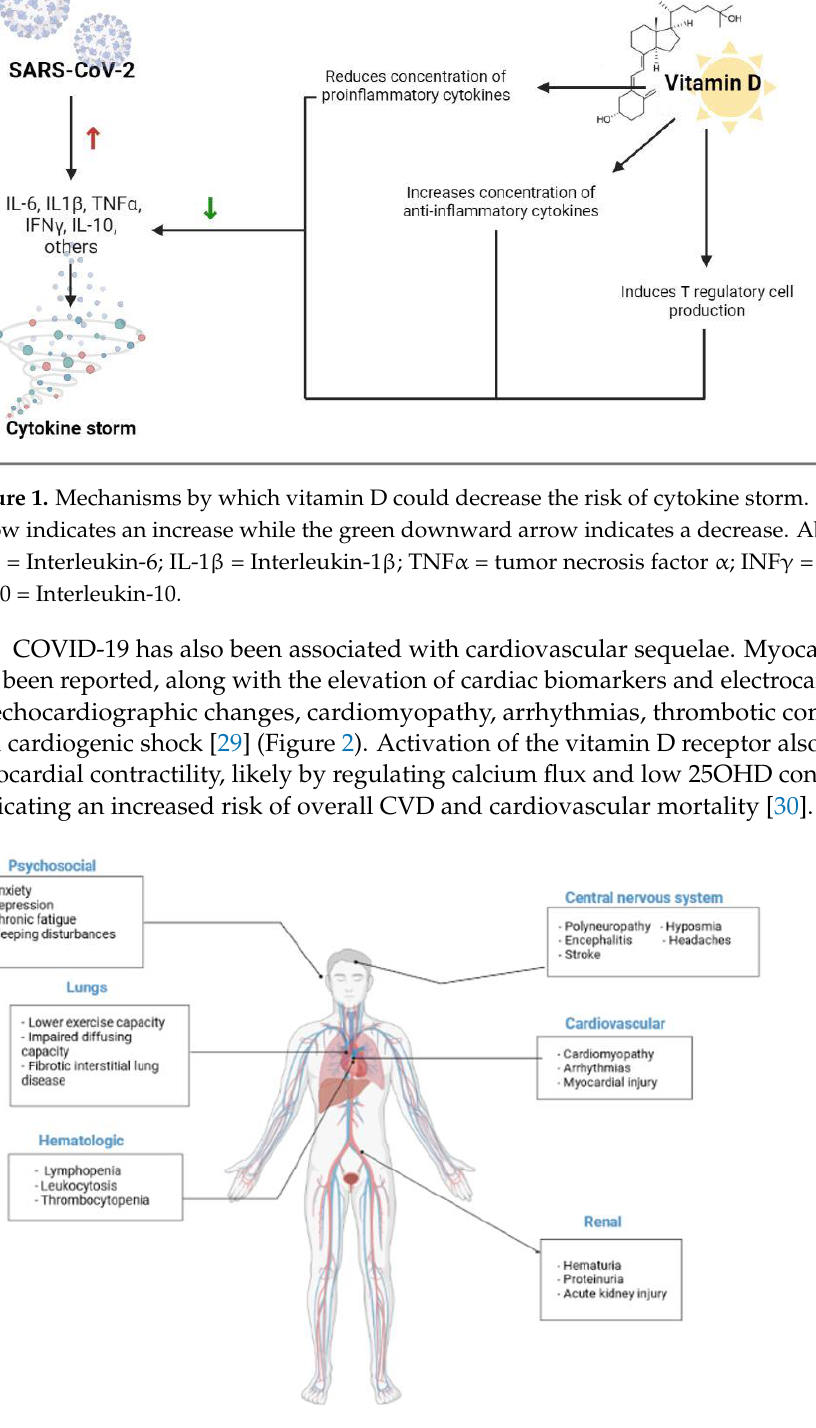
Figure 2. Potential long-term health consequences COVID-19. Some of the potential long-term manifestations are matched exercise capacity and carbon monoxide diffusing capacity, cardiovascular disorders, hematological manifestations and thrombotic complications, central nervous system, and psychosocial manifestations, as well as renal